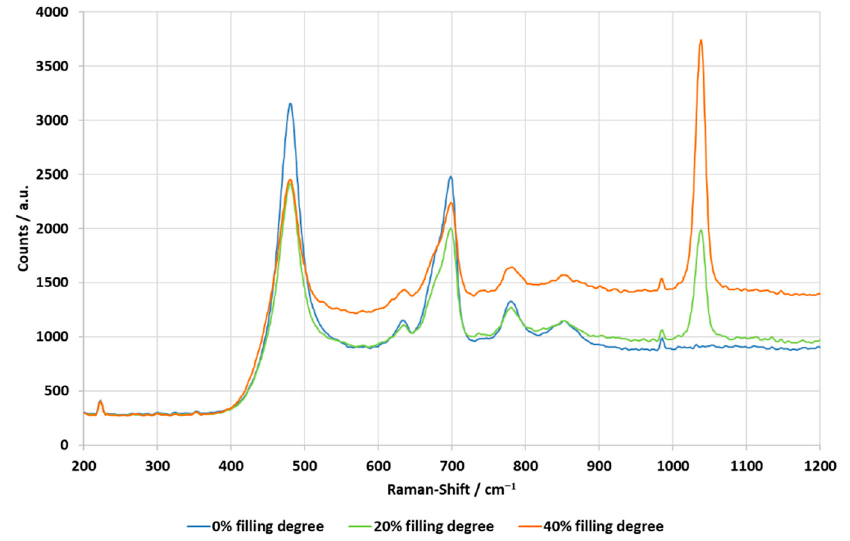
Figure 4. Section of three representative Raman spectra samples of the filling degrees of 0%, 20%, and 40%.